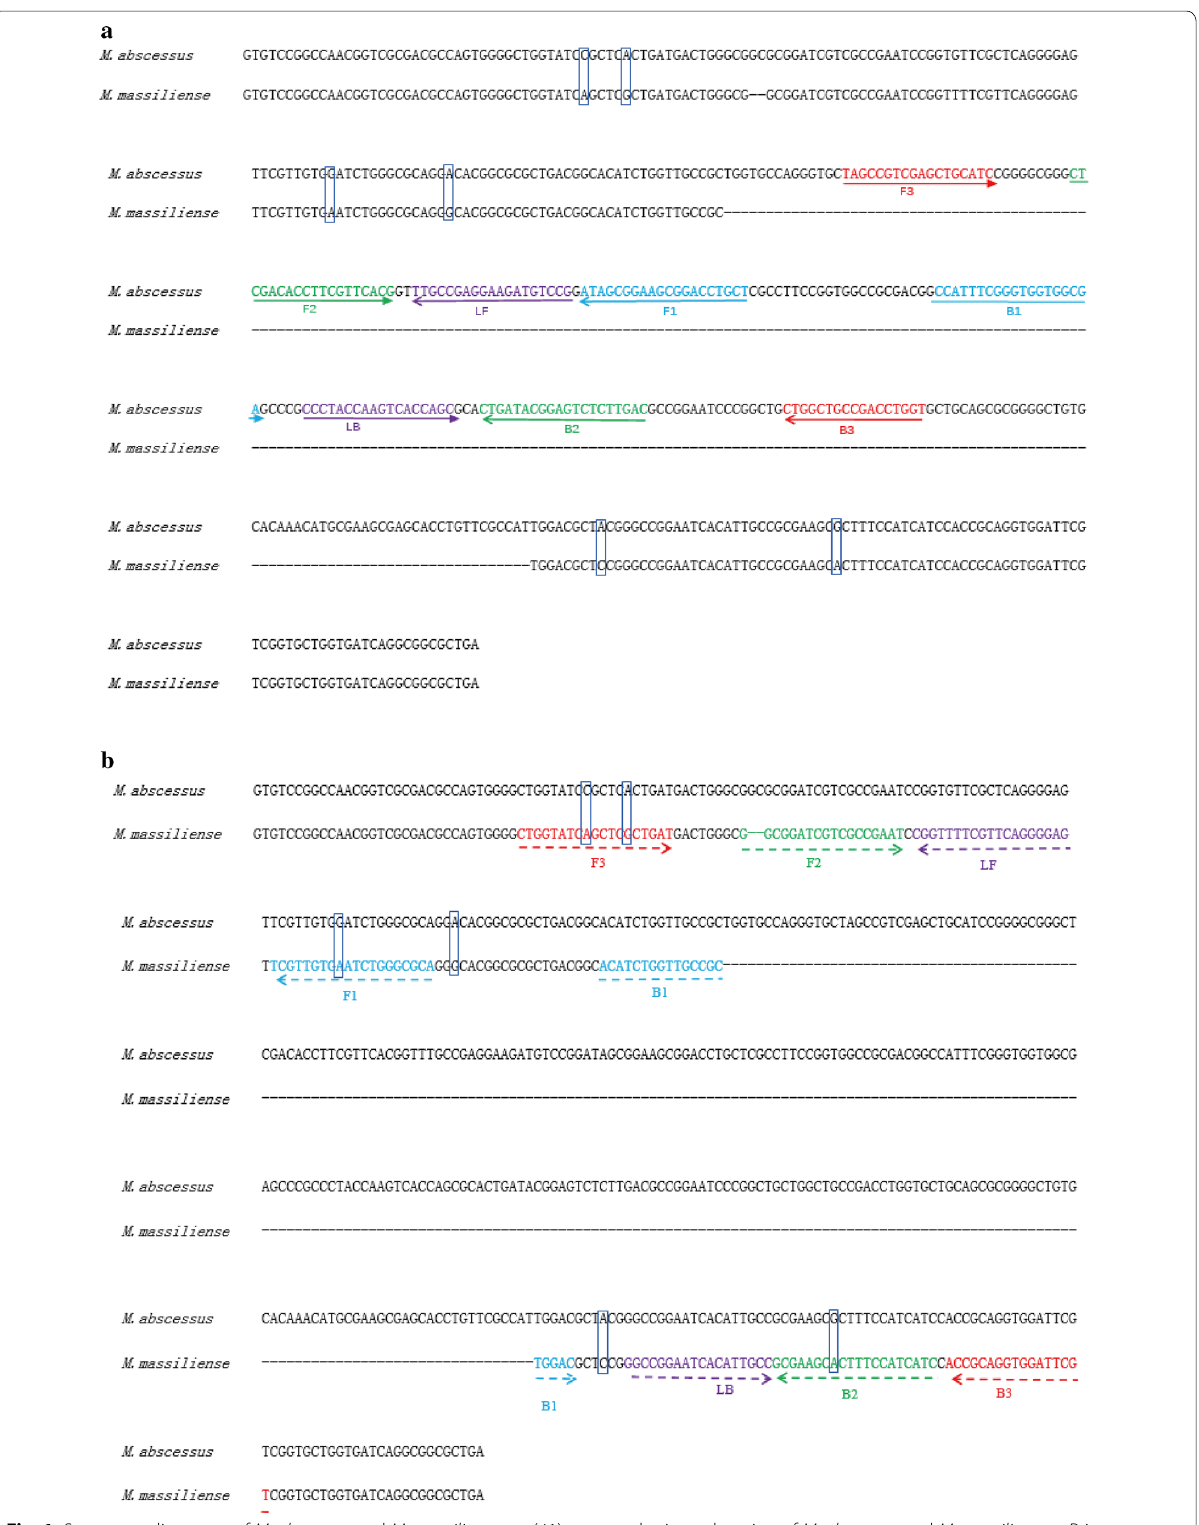
Fig. 1 Sequence alignment of M. abscessus and M. massiliense erm (41) gene and primers location of M. abscessus and M. massiliense . a Primers design for M. abscessus , b Primers design for M.